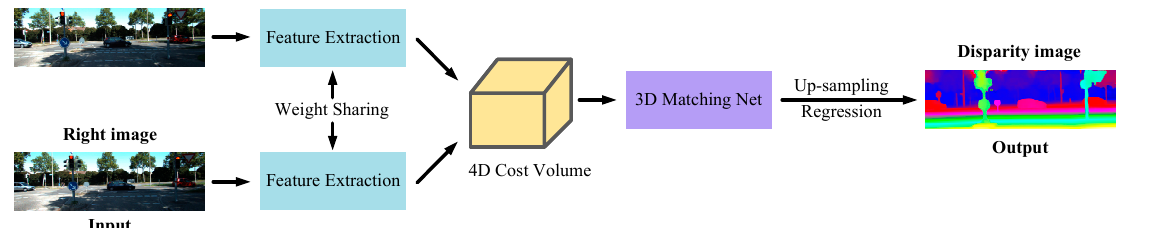
Figure 1. An overview of multi-scale dense attention network (MDA-Net).